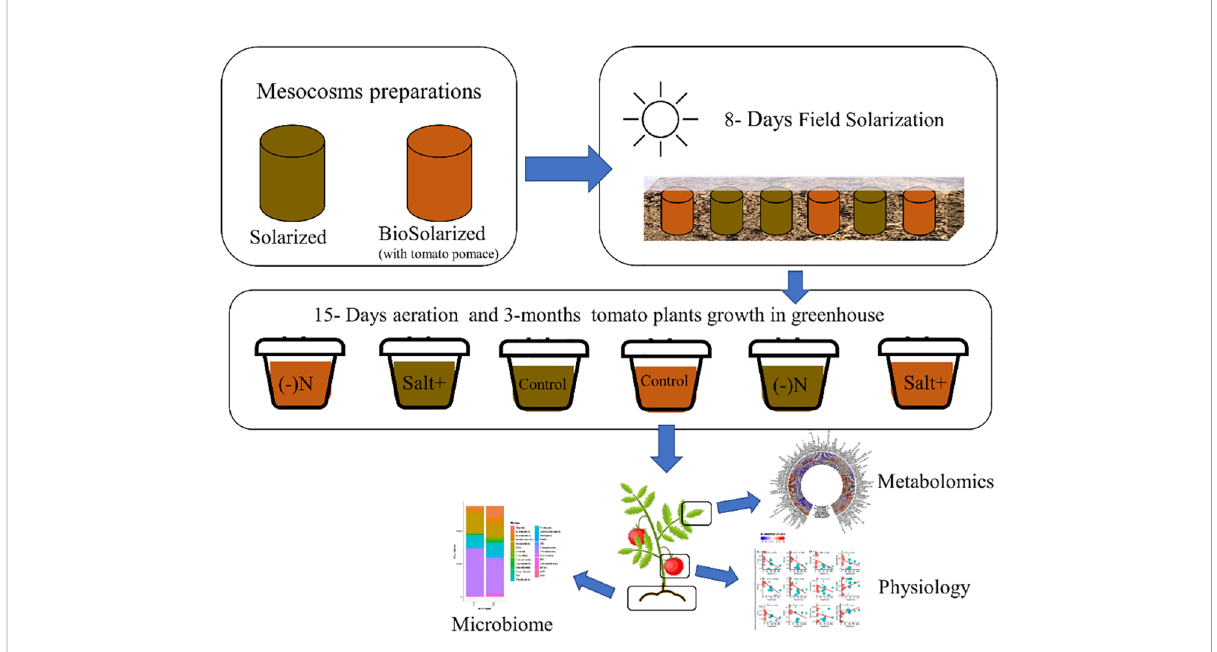
FIGURE 1 Schematic illustration of the experimental design. Starting by preparing the mesocosms for soil solarization (soil without tomato pomace) and soil biosolarization (with 2.5 w/w tomato pomace). Conducting an 8 days fi eld solarization treatment of the mesocosms. Transferring the treated soil into a controlled greenhouse and transplanting tomato plants under different stress conditions: control – without any stress, salt – adding excess salinity to the soil and Nitrogen de fi ciency – lower amount of nitrogen in the fertilization regime. After 3-months the plant were harvested and tested for their physiological characteristics (including fruit quality and yield) and leaves ’ metabolomics. Additionally the soil was taken for a microbiome